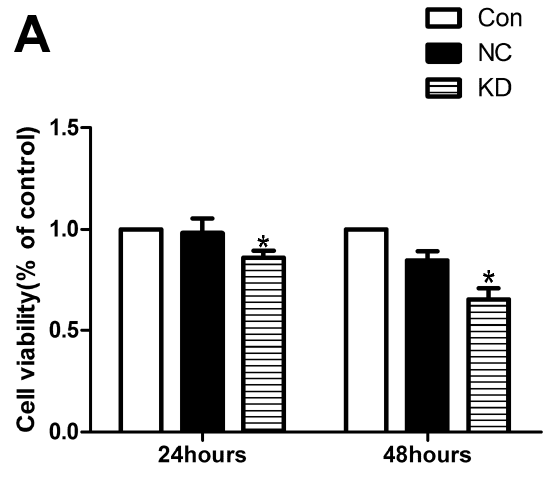
Figure 8. Cont Figure 8. Cont. Figure 8. Cont.